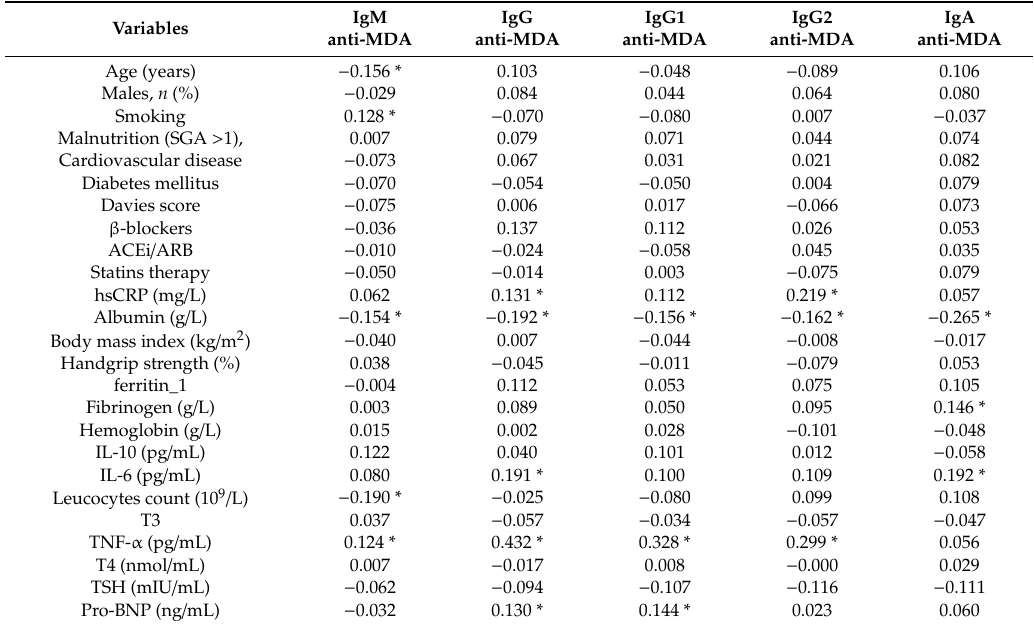
* Significant association; hsCRP, high-sensitive C-reactive protein; T3, triiodothyronine; TNF- α , tumor necrosis factor alpha; T4, thyroxine; TSH, thyroid stimulating hormone; Pro-BNP, Pro-B type natriuretic peptide. ACEi, Angiotensin Converting Enzyme Inhibitors; ARB, angiotensin receptor